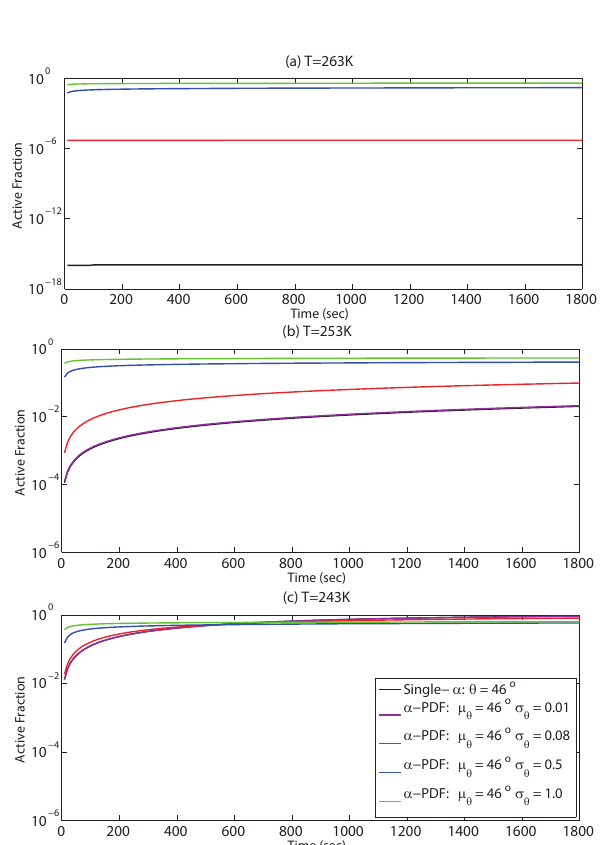
Figure 2. Calculated change in the active fraction with time at dif- ferent temperatures for 300nm monodisperse particles and for dif- ferent contact angle